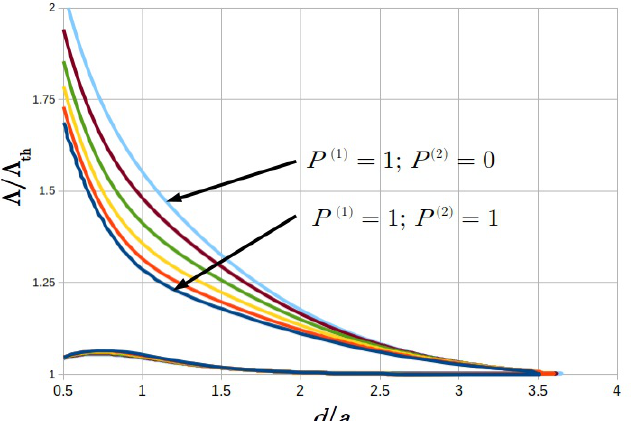
Figure 10. Stability boundary for pump ellipticity P ( 1 ) = 0 in guide ( 1 ) and varying P ( 2 ) in guide ( 2 ) from 0 to 1 in steps on 0.2.